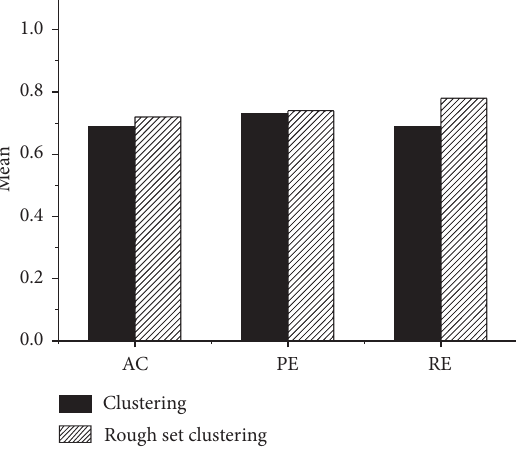
Figure 8: Comparison on performance of clustering algorithm on the Lung-Cancer data set.